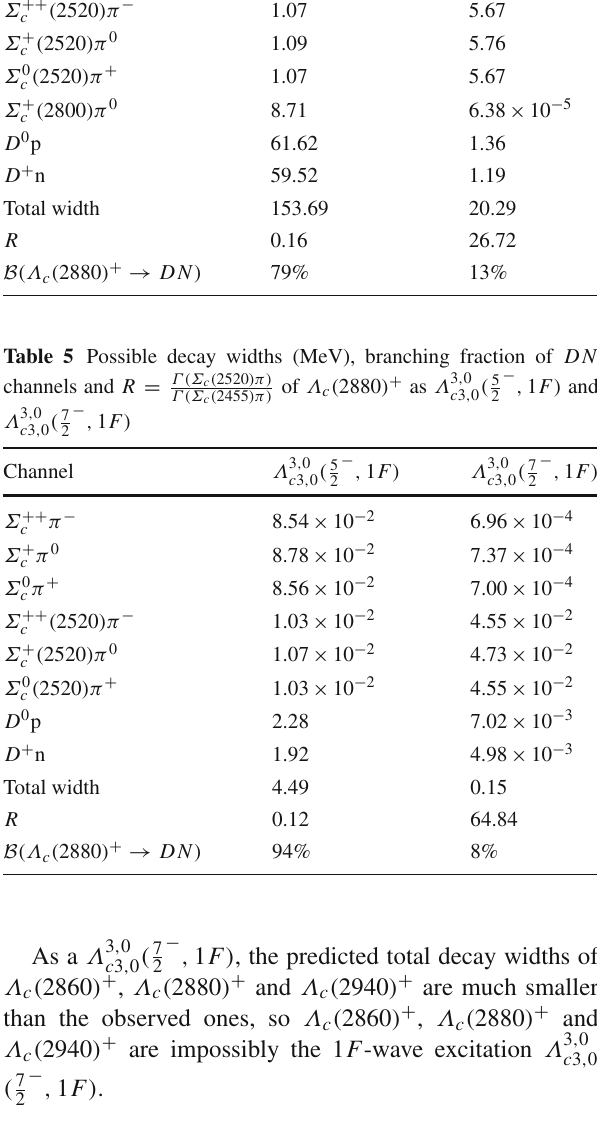
Table 4 Possible decay widths (MeV), branching fraction of DN